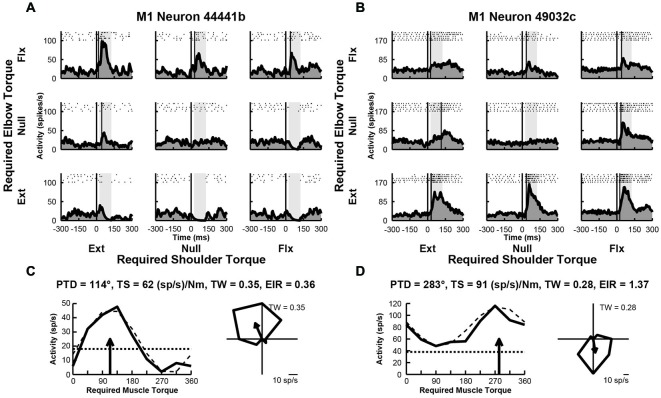
Activity of exemplar M1 neurons. (A) Rasters and histograms for each perturbation condition (arranged in joint-torque space) displaying the activity of an M1 neuron that responded maximally to perturbations that required a flexor torque at the elbow. (B) Activity of a neuron that responded maximally to perturbations that required an extensor torque at the elbow. (C,D) Directional tuning of the corresponding M1 neurons. Left sub-panels illustrate linear plots of overall activity vs. joint-torque angle. Unloaded baseline activities and cosine fits are shown as dotted and dashed lines, respectively. Right sub-panels show polar plots of the perturbation-related activity (baseline removed) in joint-torque space. PTD, preferred-torque direction; TS, torque-slope; TW, tuning width; EIR, excitation-inhibition ratio.